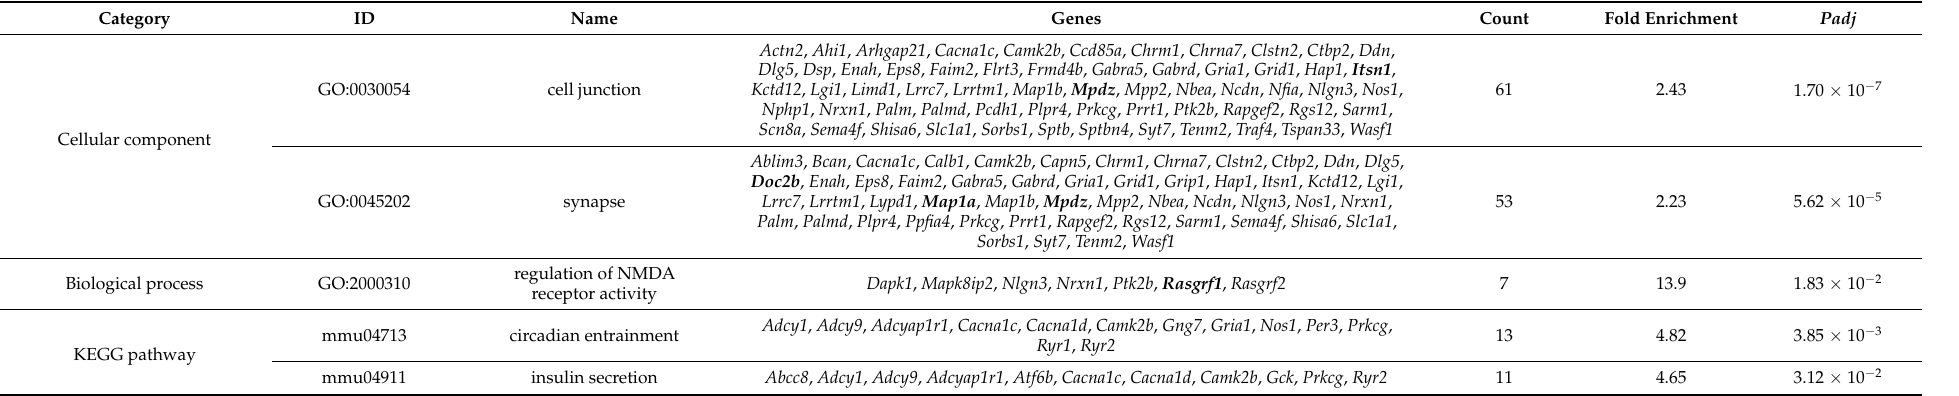
Table 8. Ontological analysis of downregulated genes (consensus and portrait scores< − 2) after FLX treatment in naive